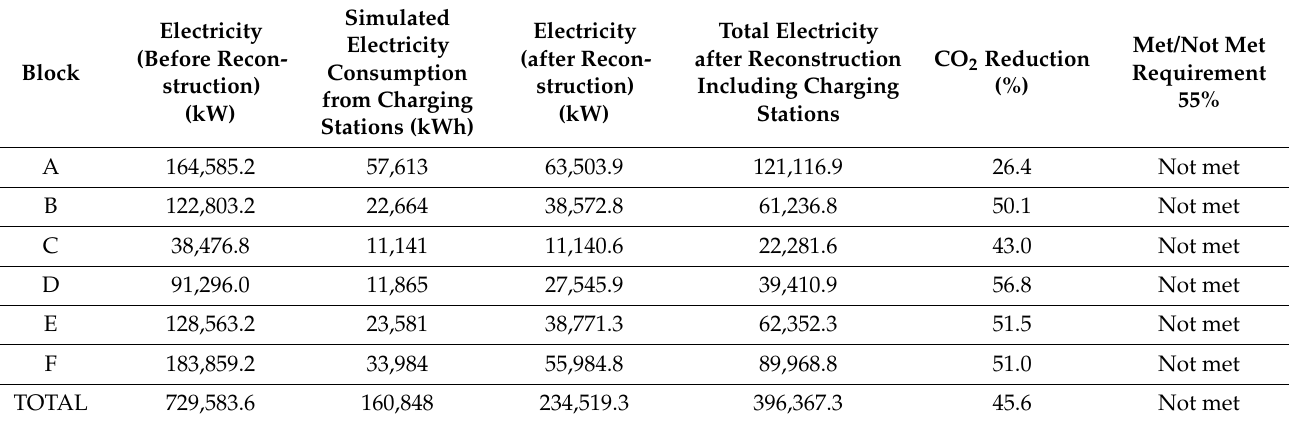
Table 27. Evaluation of CO 2 production before and after urban area reconstruction with the installa- tion of charging stations, by DB and Monte Carlo